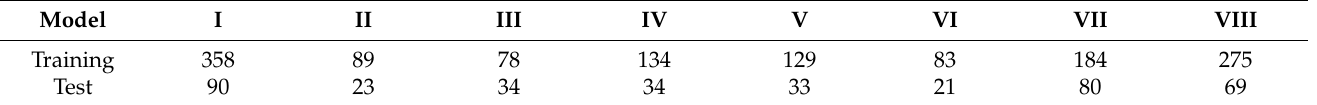
Table 8. Size of the training and test sets for each QSAR model in this